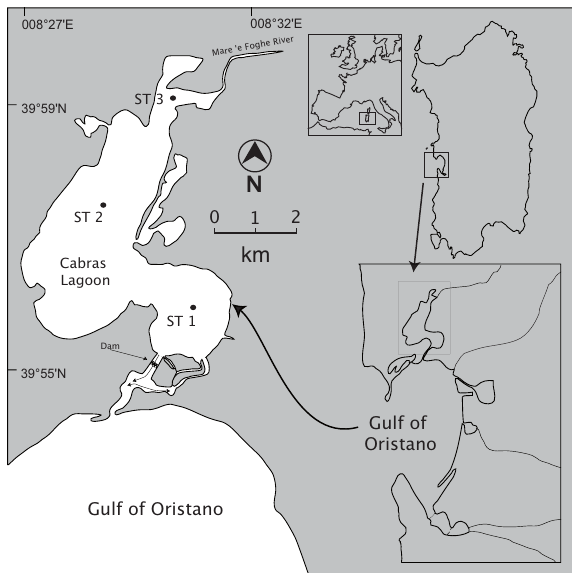
Fig . 1. – Map of Cabras Lagoon, showing its location and the sam- pling sites.